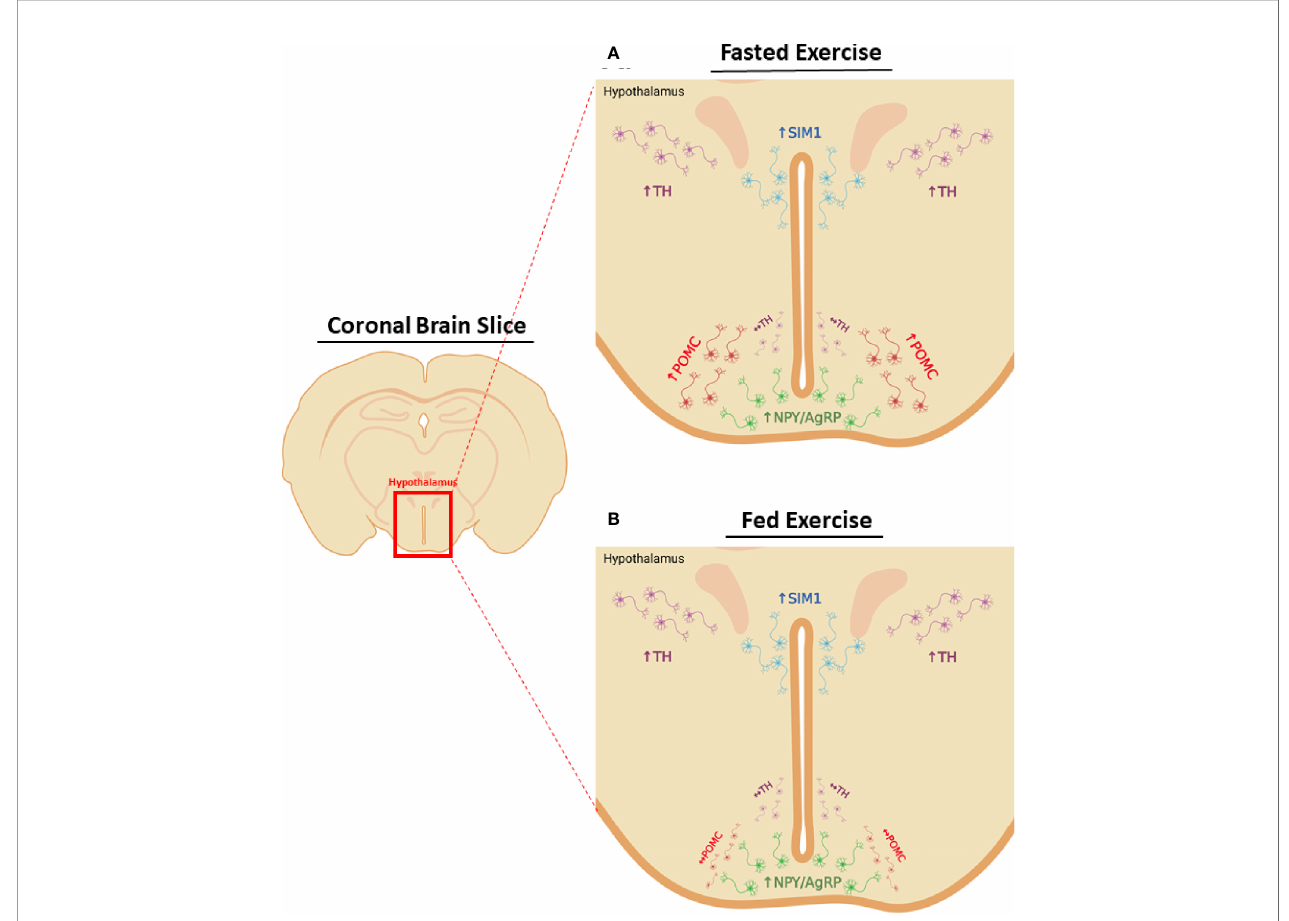
FIGURE 7 | Energy status differentially modi fi es post-exercise neuronal activity in the hypothalamus. Changes in hypothalamic neuron activity 1-hour after HIE in the (A) fasted or (B) fed status. Regardless of energy status HIE increases NPY/AgRP ARC , SIM1 PVN , and TH PVN neuron activity, with no effects on TH ARC neurons. POMC ARC neuron activity is only elevated 1-hour after fasted